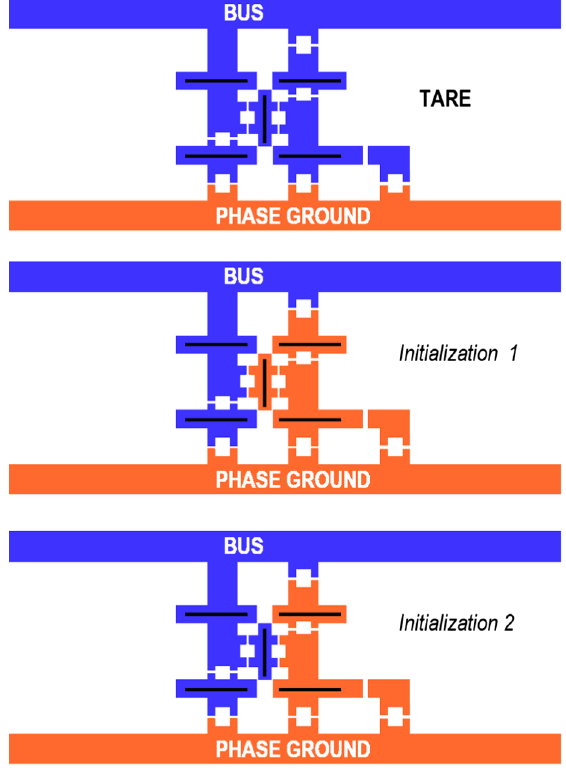
FIG. 10. Initialization process. The blue (dark gray) and orange (light gray) superconducting islands are strongly Josephson coupled to the bus and phase ground, respectively. (Top) Coupling all islands to the bus gives a measurement of the overall fermion parity of the system. This allows one to equivalently measure the parity of a qubit by coupling the constituent Majorana modes to the bus or the phase ground. (Middle and bottom) The two qubits in this device may be put ffiffiffi p 2 into the superposition ð 1 = Þðj 00 i þ j 11 iÞ by making two measurements; each measurement includes one MZM from each qubit. (Along with the tare measurement, this will also effectively measure the parity of the central